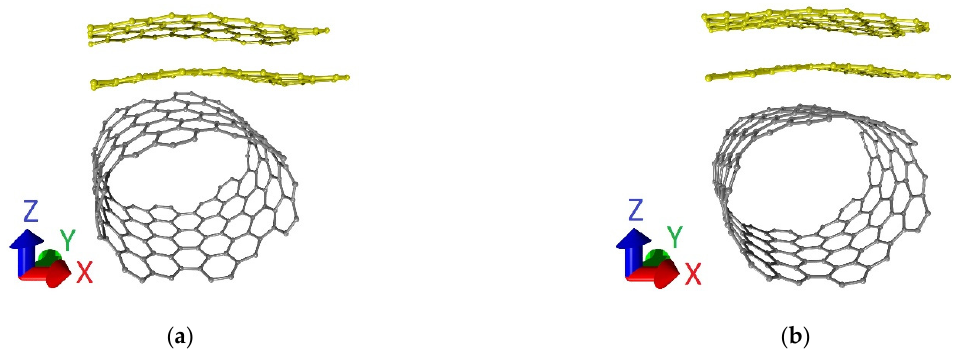
Figure 2. Supercells of bilayer graphene-SWCNT (12,6) hybrid fi lms with island topology: ( a ) model V1; ( b ) model V2.